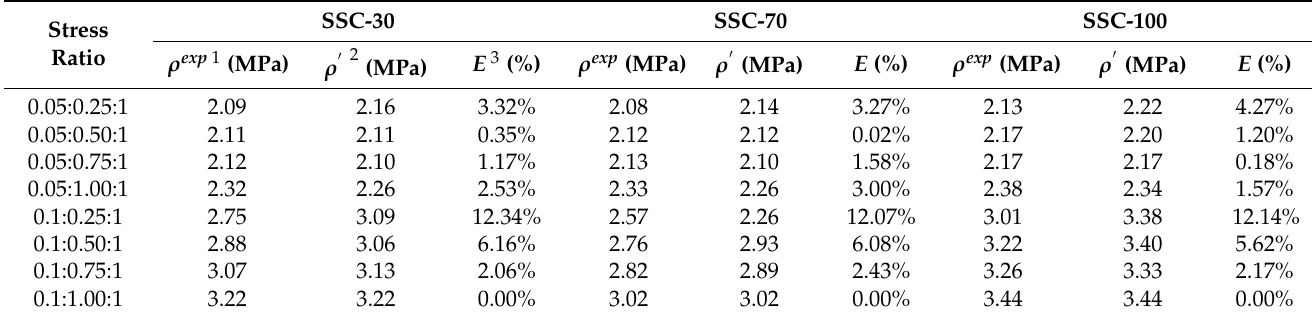
Figure 7. The meridians of SSC and the strength envelopes in deviatoric plane: ( a ) The meridians of SSC; ( b ) The deviatoric plane of SSC-30; ( c ) SSC-70; ( d ) SSC-100. Table 5. The validation of